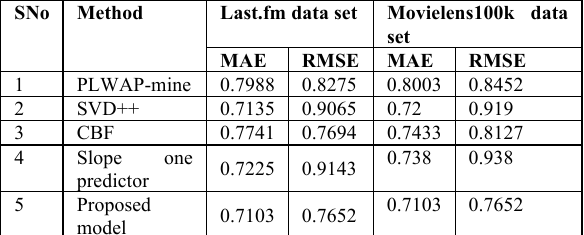
TABLE VI. MAE AND RMSE VALUES OF THE PLWAP AND PROPOSED METHODS